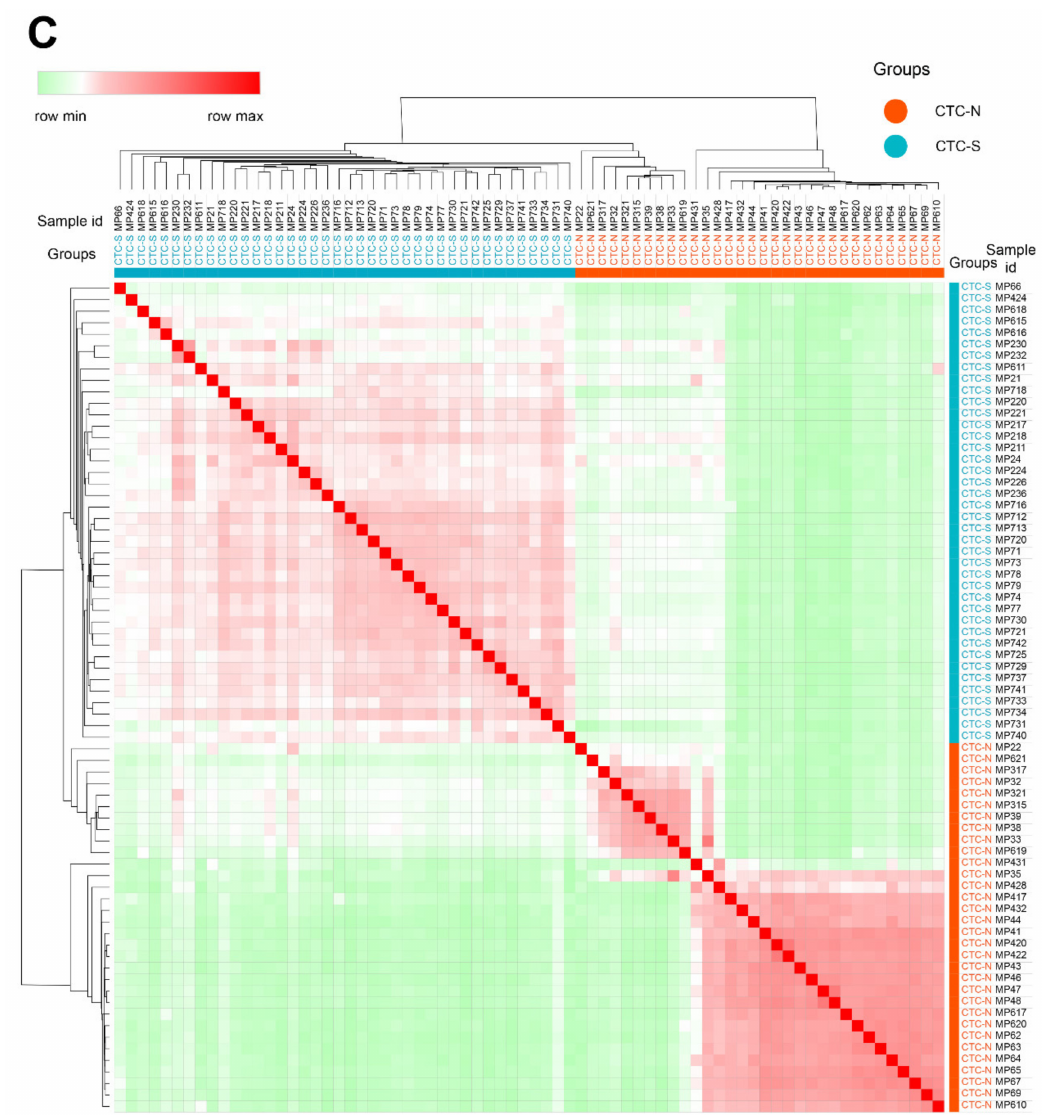
Figure 2. Defining the CTC-S and CTC-N subgroups. ( A ) Principal component analysis (PCA) loading plot of the marker set. The x and y axes represent the principal components 1 (PC1) = 16.6% variance and PC2 = 6.1% variance, respectively. 3 of the 5 stem markers (Aldh1a1, Aldh1a2, and Klf4) are located in the first quadrant, indicating that stem markers tend to correlate with both PC1 and PC2 positively. The PCA loading data were download from the ClustVis and visualized by the imageGP (available online: http: // www.ehbio.com / ImageGP / index.php / Home / Index / index.html,accessed on 23 April 2020). ( B ) PCA scores plot of 72 samples. All samples were divided into three clusters. The cluster located in the first quadrant was defined as CTCs with stem-like features (CTC-S) since they present with stem markers PCA loadings in (A), as the other two clusters were combined and defined as CTC with non-stem-like features (CTC-N). The corresponding ellipses were plotted based on a 95% probability from the same group. ( C ) The correlation heatmap was visualized by MORPHEUS (available online: https: // software.broadinstitute.org / morpheus / , accessed on 7 March 2020). We chose the average linkage method to perform the hierarchical clustering. The heatmap demonstrates the distinct subgroups of CTC-S and CTC-N. The colors of the square matrices illustrate the Pearson’s correlation coe ffi cient, with red indicating a strong correlation and green a weak correlation. All samples are listed in the same order in both horizontal and vertical